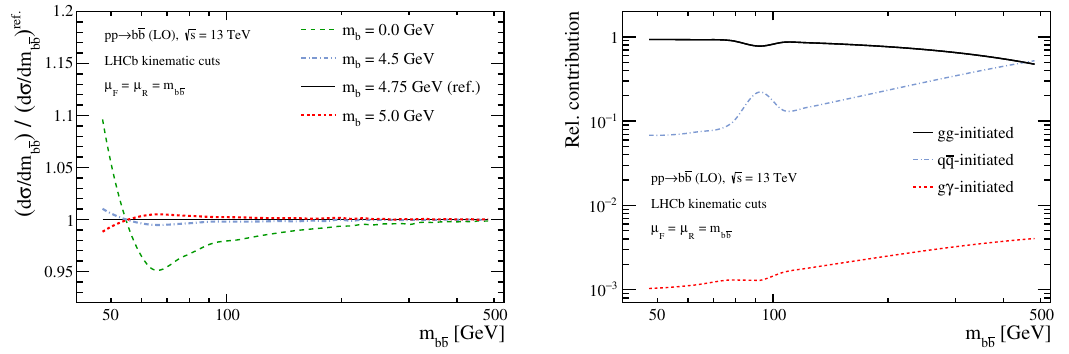
Figure 1 . Left: di(cid:11)erential cross sections for producing b -jet pairs for di(cid:11)erent choices of m b , normalised to the result obtained with m b = 4 : 75 GeV. Right: relative contributions of each partonic channel to the di(cid:11)erential cross section for the choice m b = 4 : 75 GeV. The shown results p are LO accurate and correspond to pp collisions at s = 13 TeV, employing the selections (2.2). would have the advantage that logarithmic mass corrections could be resummed, but